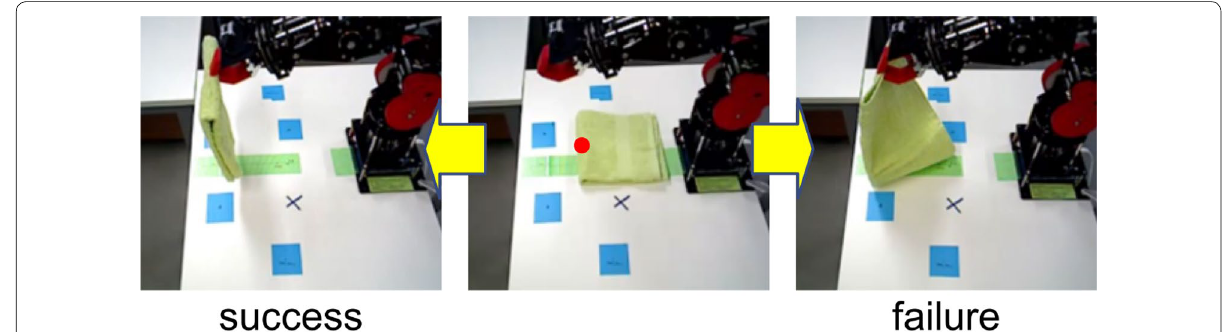
Fig. 1 Picking up a folded cloth product: success and failure